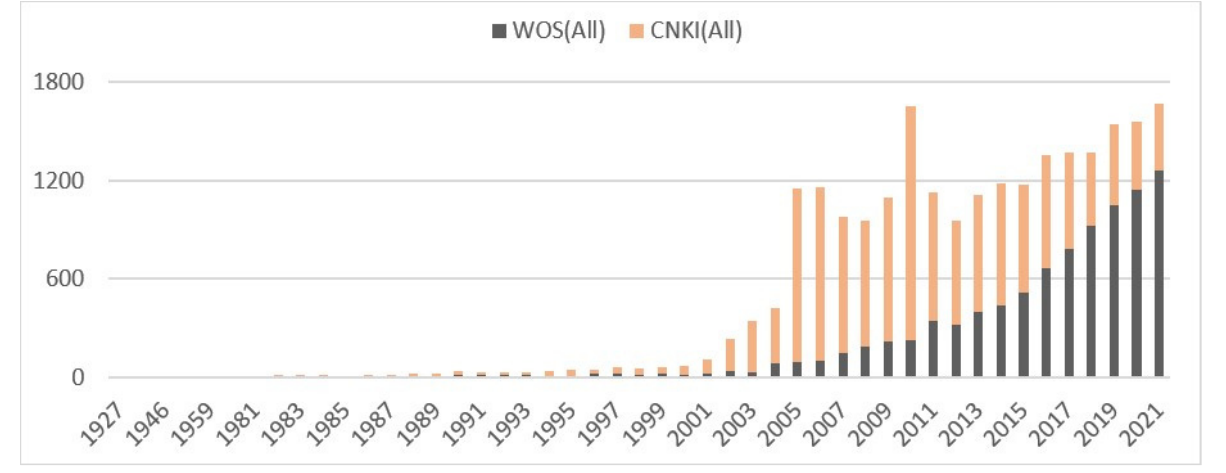
Figure 1. Number of studies on coal mine accidents in China based on preliminary